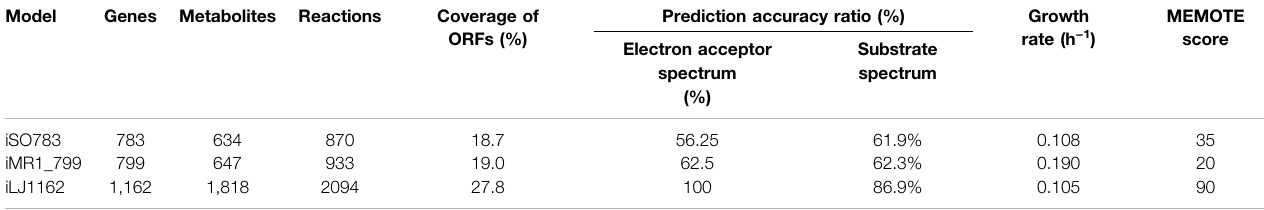
TABLE 3 | Comparison of results among three GEMs of S. oneidensis MR-1.